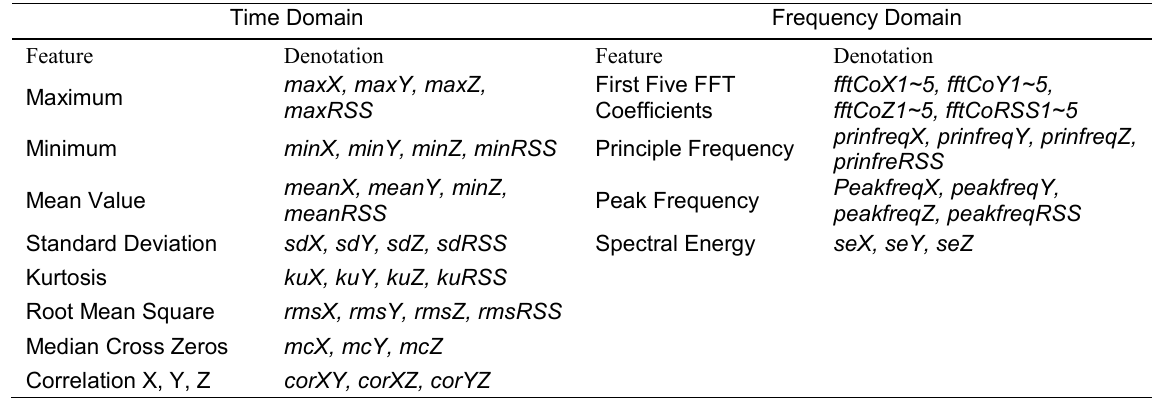
Table 1. Features and denotations in Feature Set I.